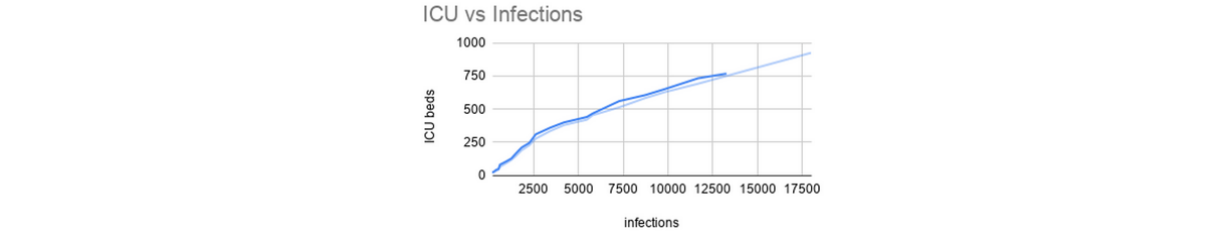
Figure 3. Correlation between occupied ICU beds and COVID-19 infections. ICU: intensive care